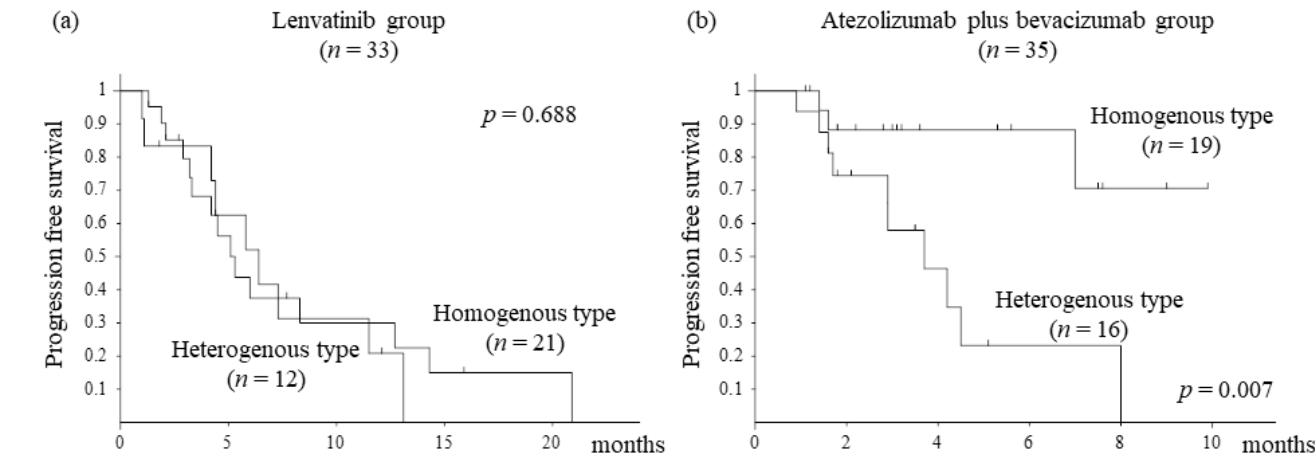
Figure 1. Progression-free survival stratified by EOB-MRI visual assessment: ( a ) Kaplan–Meier curve of progression-free survival (PFS) in the lenvatinib group ( n = 33). The median PFS with homogenous and heterogeneous types is 5.1 months and 6.4 months, respectively. There is no significant difference in PFS between the homogenous and heterogeneous types ( p = 0.688, log-rank test). ( b ) Kaplan–Meier curve of PFS in the atezolizumab plus bevacizumab group ( n = 35). The median PFS is not attained with homogenous type and 6.4 months in heterogeneous type. Moreover, PFS is significantly better in the homogenous type than in the heterogeneous type ( p = 0.007, log-rank test).